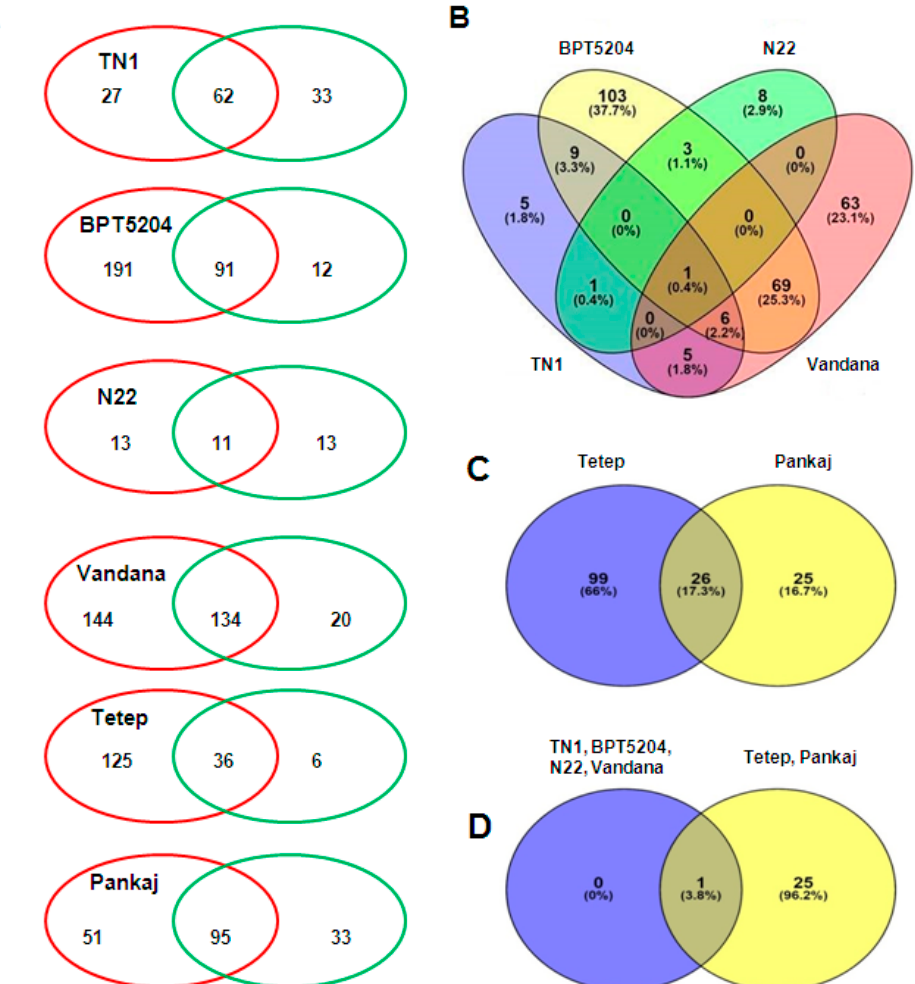
Figure 3. ( A ) Venn diagrams showing common and exclusively expressed miRNAs under the R. solani -infected and control conditions. The red color circle represents the R. solani -infected samples, whereas the green color circle represents the control samples. ( B ) Venn diagram of miRNAs showing exclusive expression (under R. solani infection) in susceptible rice cultivars. ( C ) Venn diagram of miRNAs showing exclusive expression (under R. solani infection) in tolerant rice cultivars. ( D ) Venn diagram of miRNAs showing exclusive expression (under R. solani infection) in tolerant and susceptible rice cultivars.